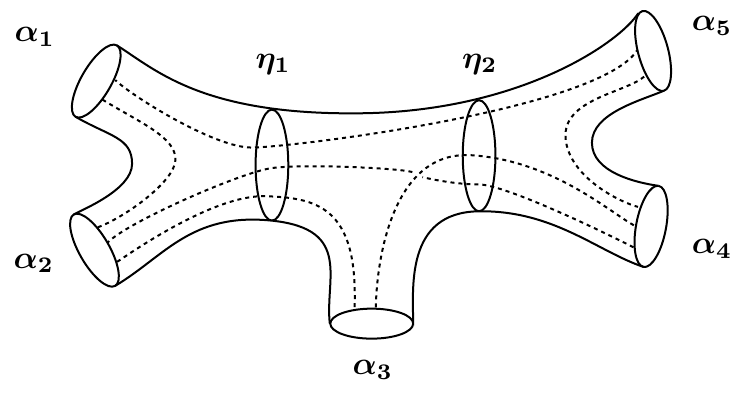
Figure 5 . Pants decomposition of the (cid:12)ve-point function hO 1 O 2 O 3 O 4 O 5 i , with intermediate states denoted by O (cid:17) and O (cid:17) . Although this (cid:12)gure has a (cid:12)xed number of bridge lengths, the sum over 1 2 f ‘ g has already been performed in our ij